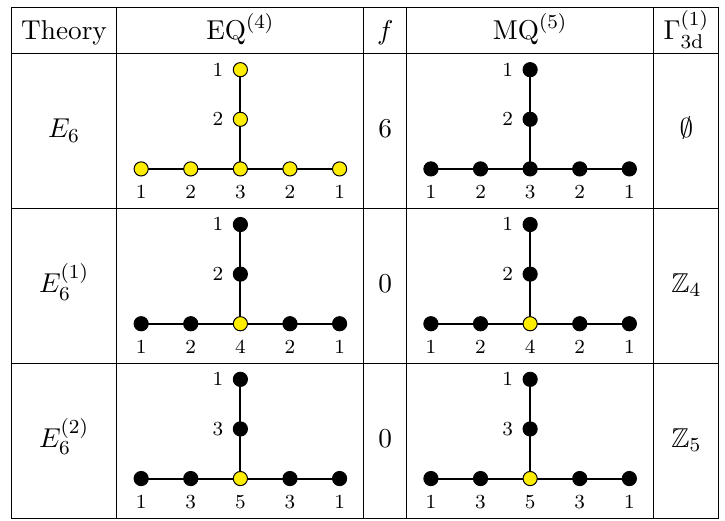
Table 4 . EQ (4) and MQ (5) for the r = 1 E 6 theories. Here we present the ‘electric’ (‘ SU( N ) quiver’) version of each theory, which has a one-form symmetry Γ (1)